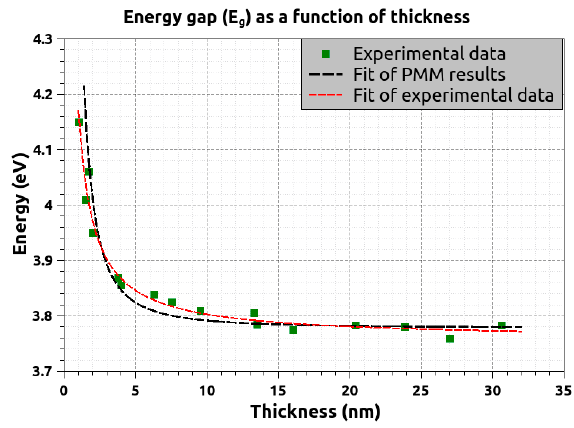
Figure 7. Direct band gap energy E g of ultrathin NiO films as a function of film thickness t by experiment and theory. Some experimental data from Ref. [17] have been also included. The black dashed line is derived by fitting the calculated values of E g on E g = a + b / t c ( a , b , and c are fitting parameters and t is the film thickness) while the red dashed line is a fit of the experimental data on the same function.